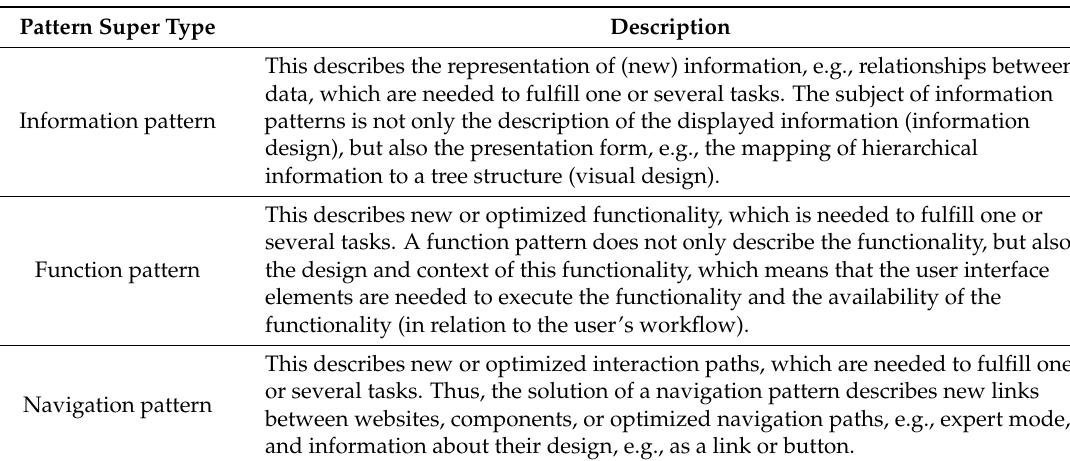
Table 4. Pattern super types and